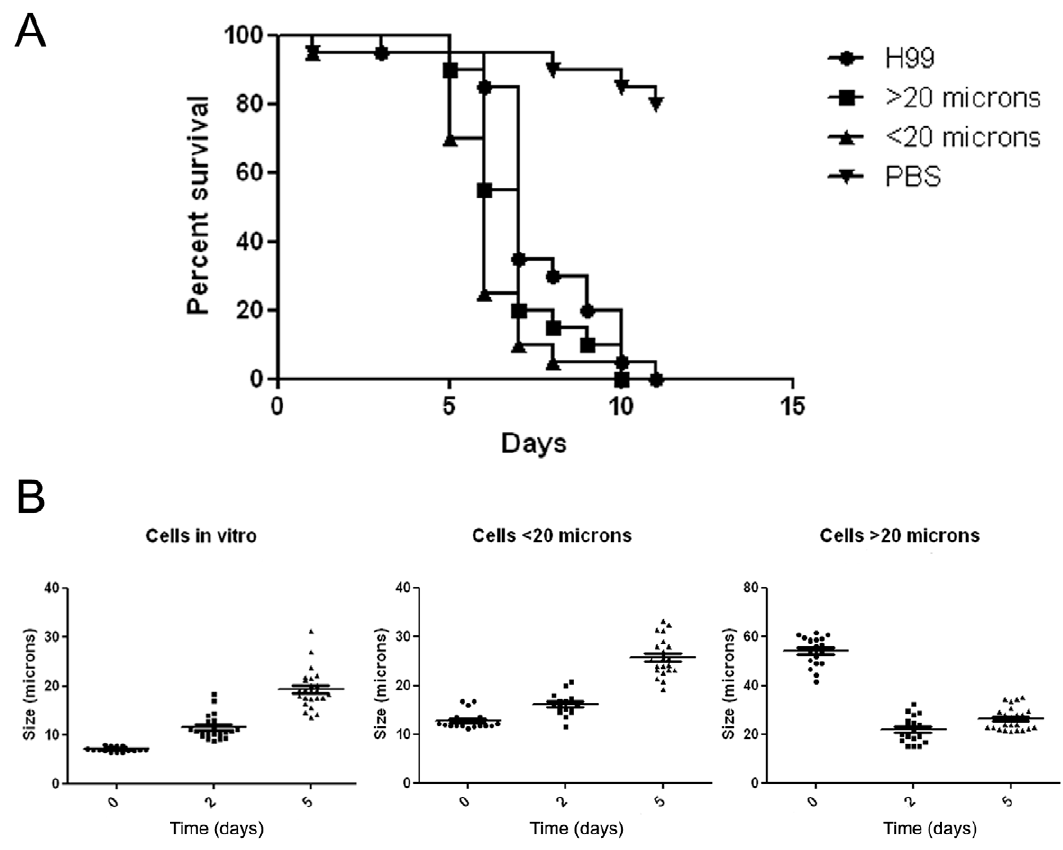
Figure 8. Survival of G.mellonella infected with giant cells isolated from mice. A ) Balb/c mice were infected with H99 strain, and after 17 d, yeast cells recovered from the lungs were separated according to their size. Two different samples were obtained: cells smaller than 20 m m or cells larger than this size. Yeast cells incubated overnight in Sabouraud were carried out in parallel. Twenty larvae per group were inoculated with 10 m L of 3 6 10 5 /mL suspension of the 3 different C. neoformans preparation: Sabouraud (indicated in the figure as H99), cells from mice of regular size ( , 20 m m) and giant cells ( . 20 m m). Since yeast cells from mice were treated with Streptomycin to reduce bacterial contamination (see Material and Methods), a group of larvae was inoculated with 1% Streptomycin in PBS as a control. B ) Distribution of cells recovered from caterpillars from the different groups at different times of infection (days 0, 2 and 5).